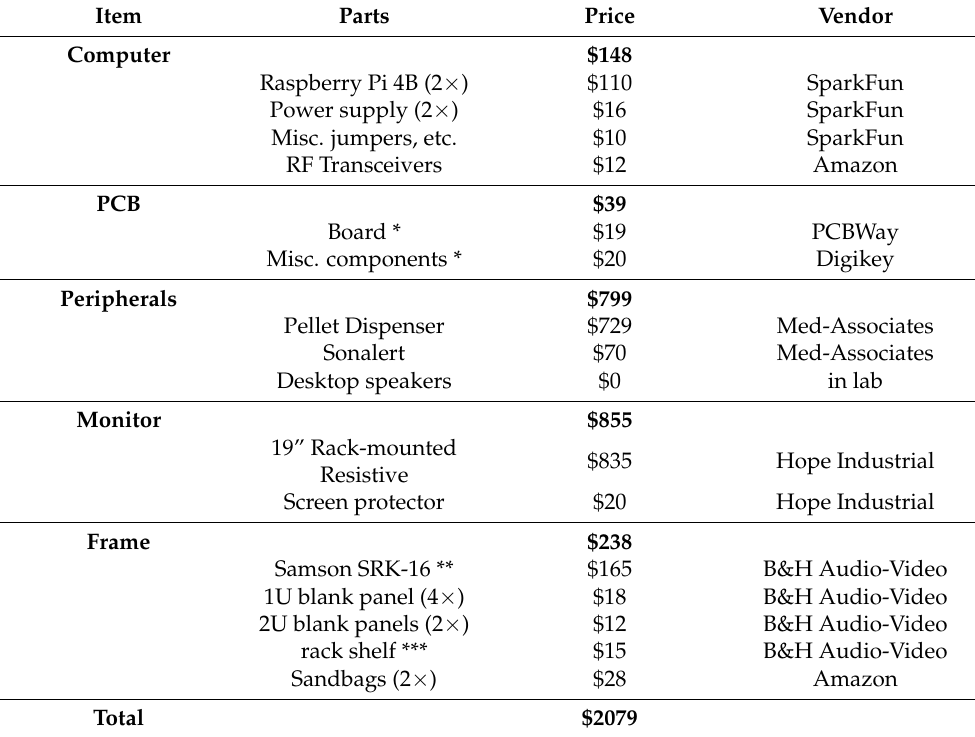
Table 1. List of physical components and pricing as of purchase. Sums in each category are given in bold. * The board and components were purchased as a set of 5 to meet minimum order thresholds; price given is per board. ** A smaller rack would have been suitable even for the large Yorkshire pigs. Future builds will use the SRK-12 (12U height). *** The rack shelf was not explicitly necessary, but gave easy access to the Raspberry